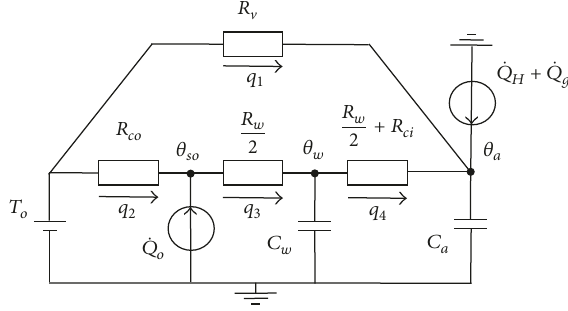
Figure 2: Thermal network for the heat balance